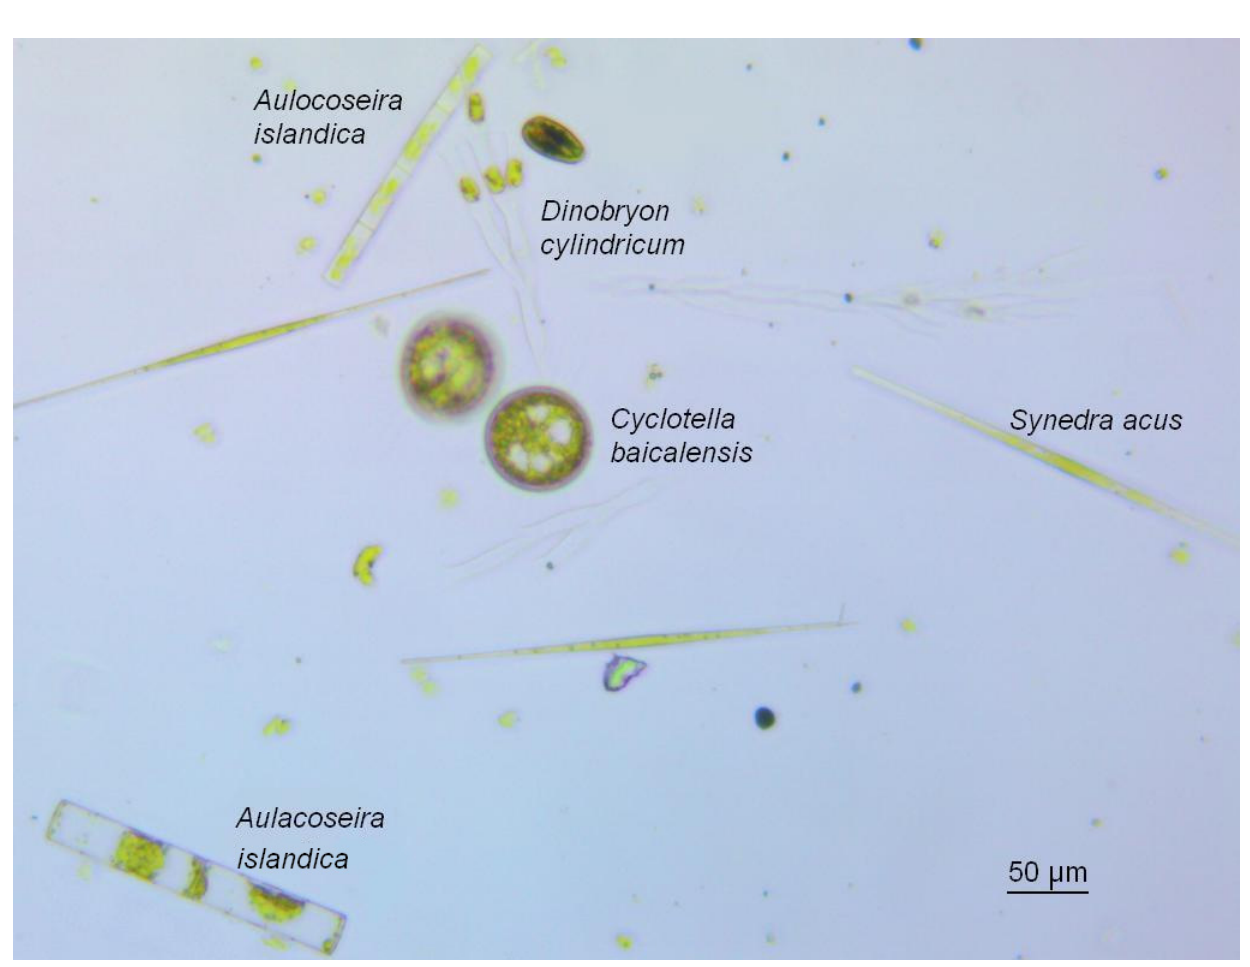
Figure 2. Some large-volume and long-sized algae in phytoplankton of Lake Baikal during the spring season 2020. Sample site no.